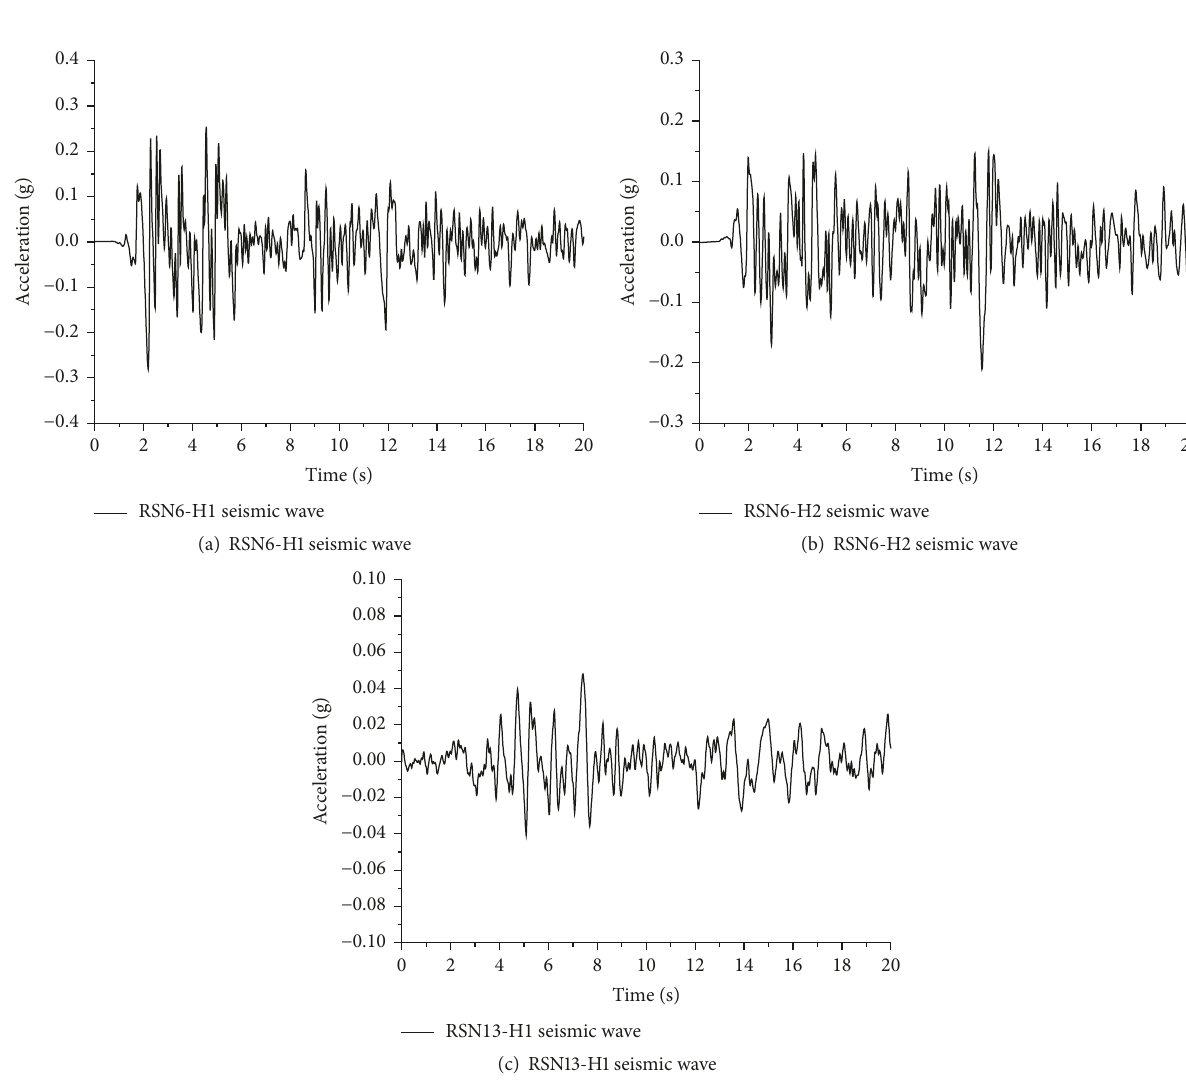
Figure 8: The time-history curves of recorded seismic